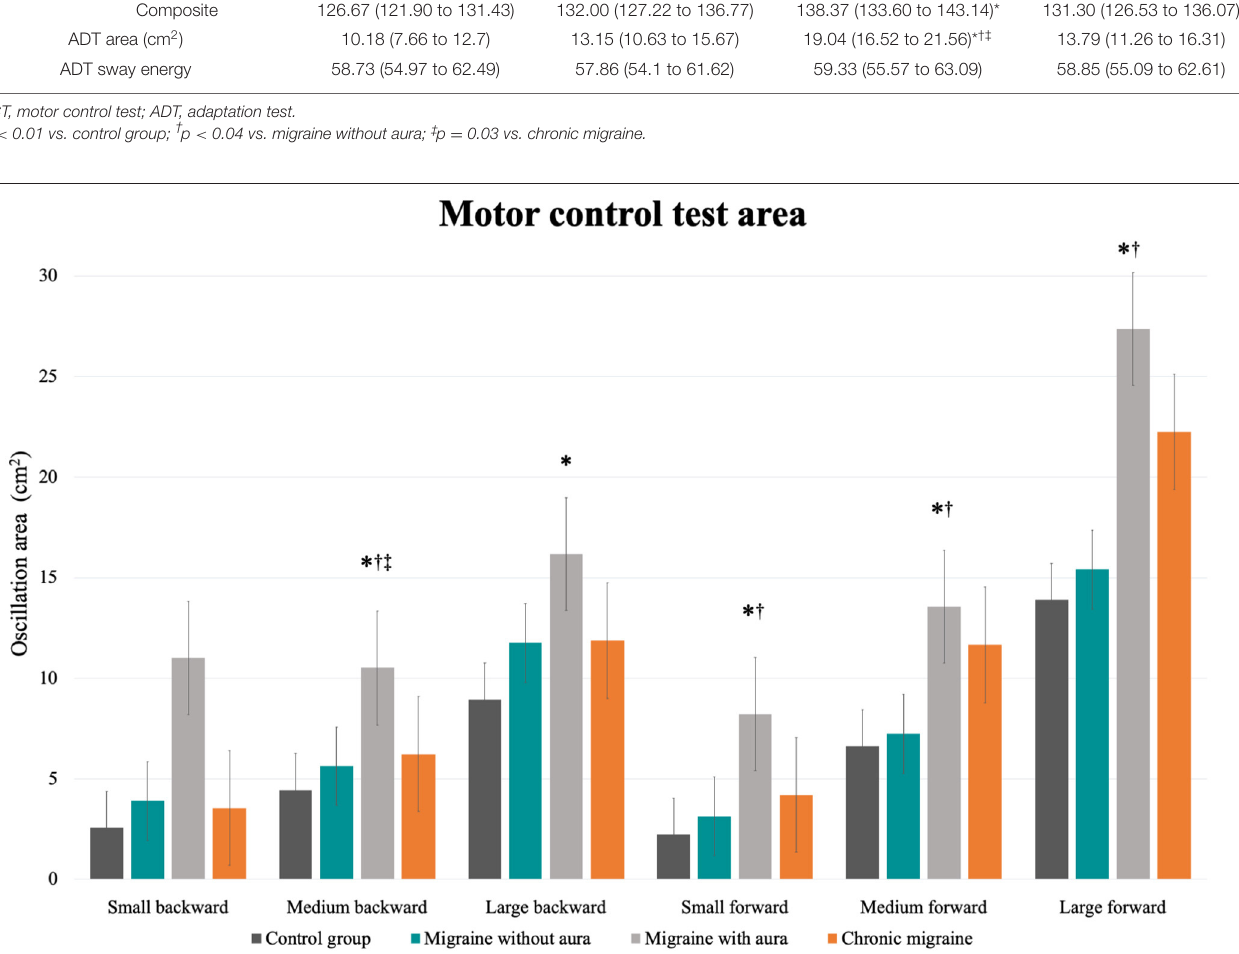
10.49) vs. CG: 2.21 ( − 0.04 to 4.48), vs. MoA: 3.12 (0.86 to 5.39); F = 5.38, p = 0.002], medium [MA: 13.54 (10.43 to 16.66)